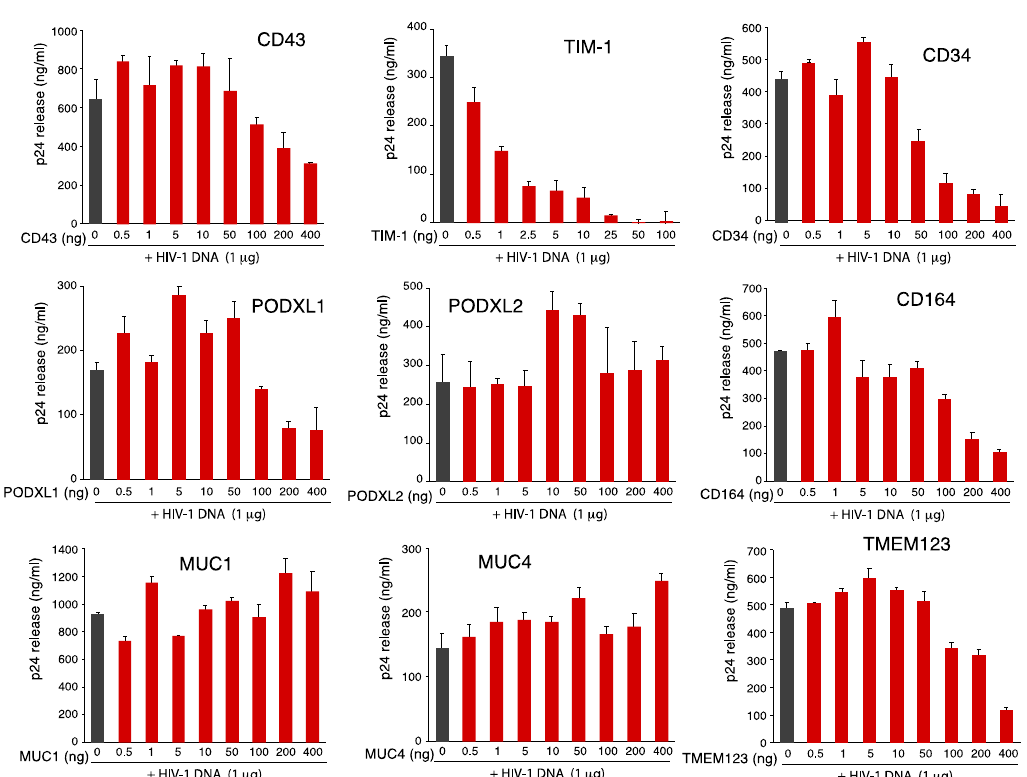
Figure 3. Effects of SHREK proteins on HIV-1 viral release. HEK293T cells were cotransfected with HIV(NL4-3) DNA (1 µg) plus each individual SHREK expression vector (0.5 to 400 ng of DNA). Virion release was quantified at 48 h post cotransfection by HIV-1 p24 ELISA. Data are represented as mean ± SD from ELISA triplicate. Experiments on the effects of TIM-1 were independently repeated 3 times (Figure S12), and experiments on effects of other SHREKs were independently repeated twice.